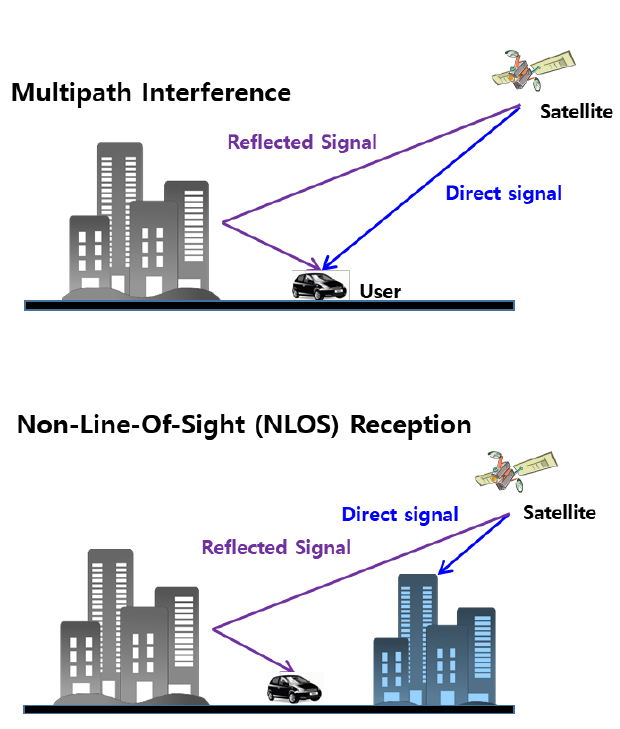
Figure 1. Multipath interference (where direct and reflected signals coexist) and non-line-of-sight (NLOS) reception (where only the reflected signal exists).